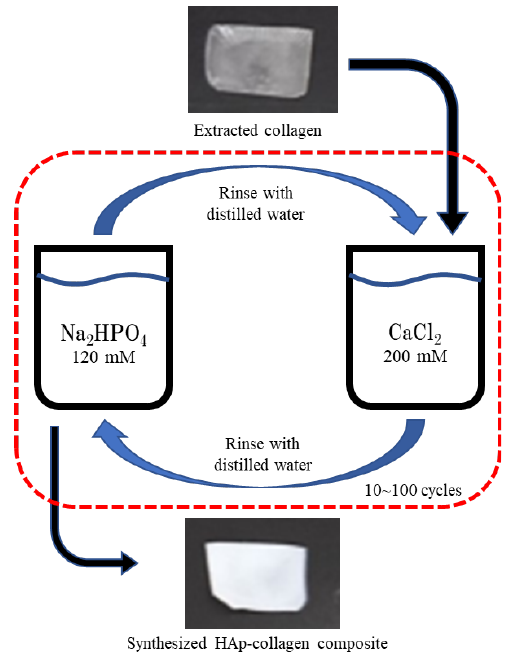
Figure 3. Method for synthesis of HAp-collagen composite films.